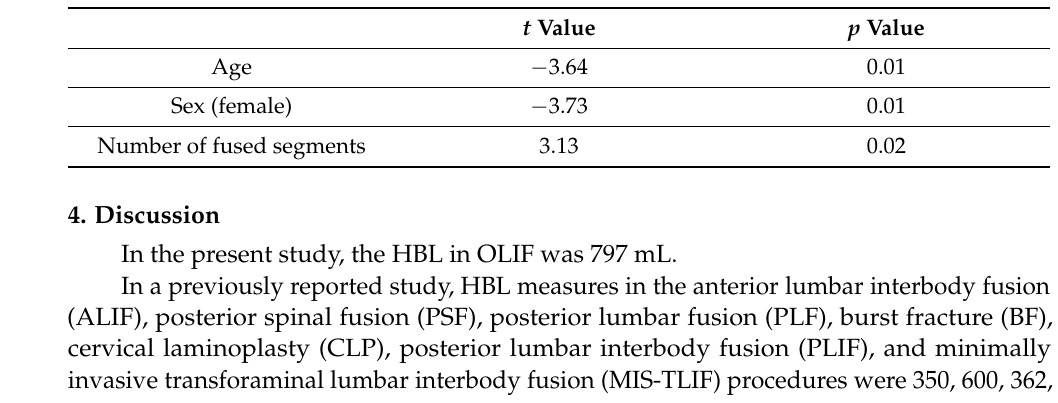
Table 2. Factors that influenced HBL in stepwise multiple regression